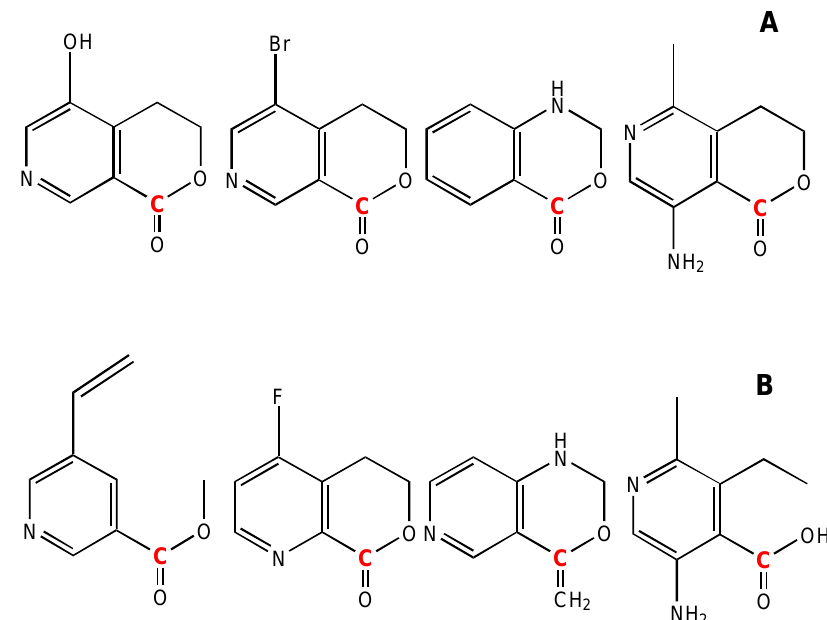
Figure 16. A: structures used to estimate the carbon atom (colored in red) chemical shift of 1-Degenerated GACF in Figure 15. B: structures which cannot be used for this